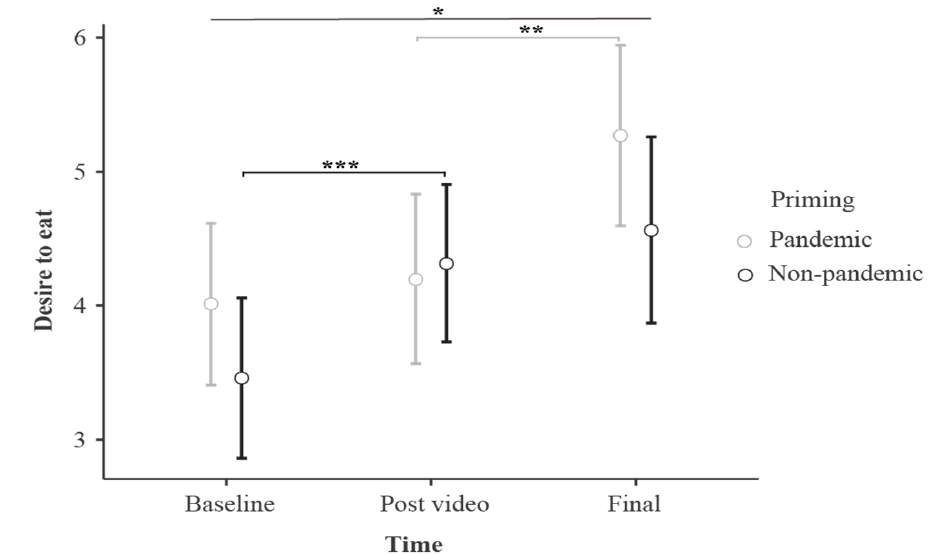
Figure 6. Desire to eat at the different time points of the experiment. The image depicts the main effects of desire to eat throughout the task, considering the different time points. Namely, the (*) Final assessment revealed higher desire to eat ratings when compared to the Baseline in both Pandemic and Non-Pandemic conditions, (**) the Final evaluation showed higher desire to eat ratings when compared to the Post-video evaluation in the Pandemic condition, and (***) the Post-video revealed higher desire to eat ratings when compared to baseline assessment in the Non-Pandemic condition. Bars indicate confidence intervals (95%), p <